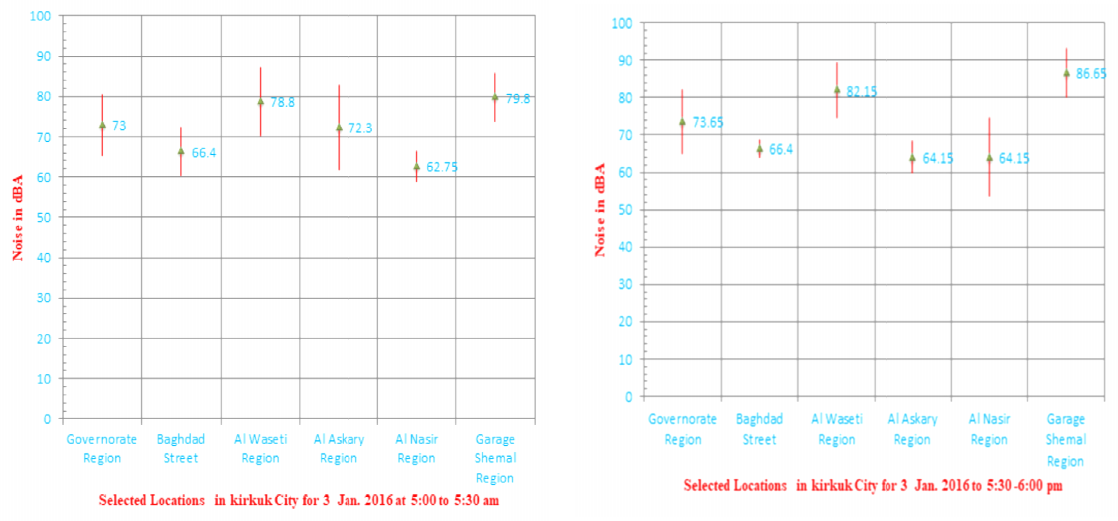
Fig. 9. Max , Min and Average Hourly Noise Distribution for the traffic flow 3 Jan. 2015 Kirkuk City.